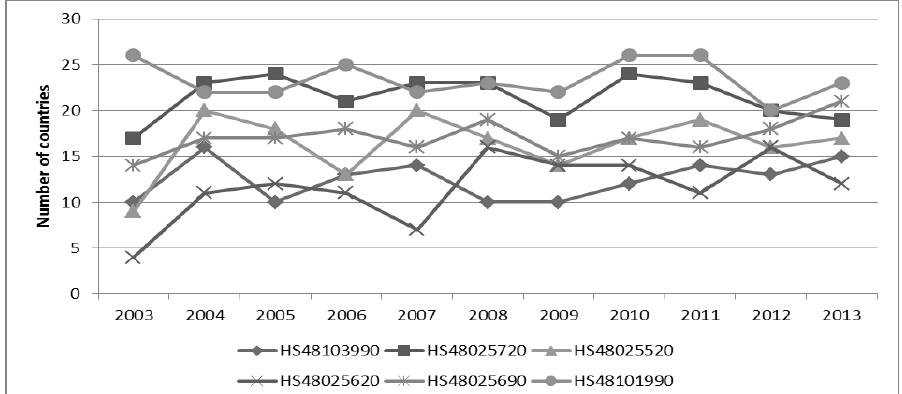
FIGURE 4: Number of countries where imports come from Source: Data from Quantec,